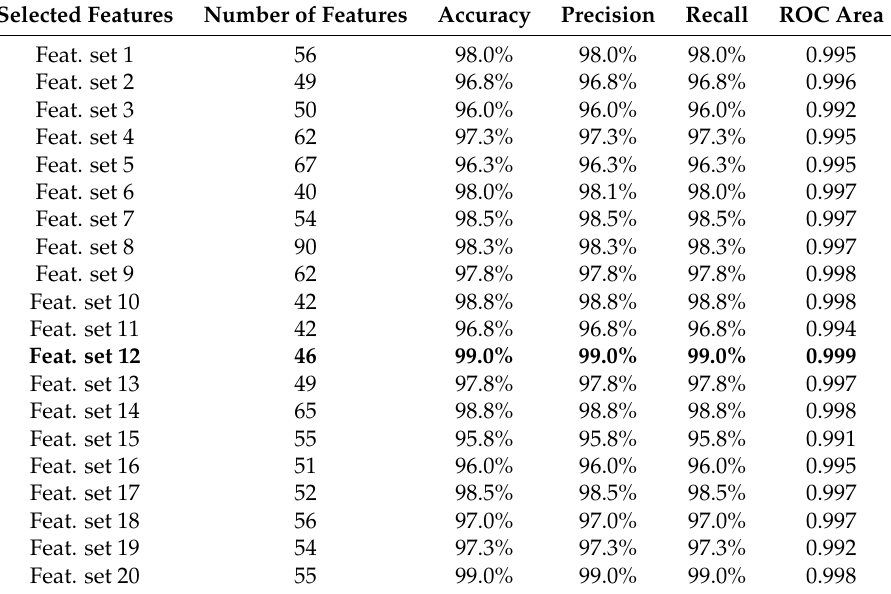
Table 4. Detection of normal or abnormal using BGWO with wavelet